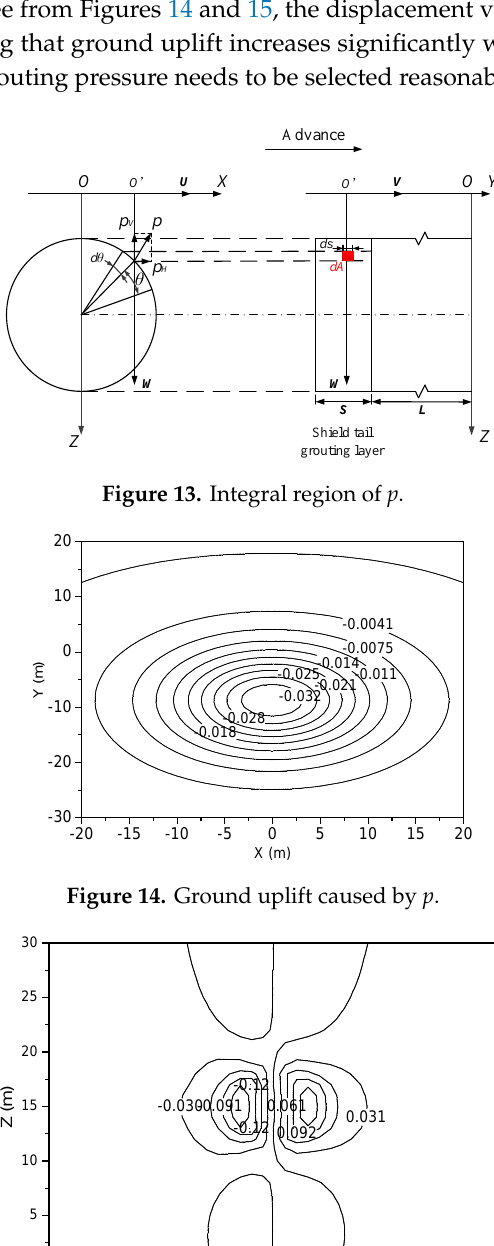
Figure 16. Ground uplift of different p . 5. Verification by Field Monitoring Data The stratum displacements induced by various effect factors and total displacement are shown in Table 3. The effect ratio of ground loss is over 95%, which plays a decisive role. The ratios to total of frictional force f d and f s are much less than 1%; they are too small to be considered. The ratios of additional thrust q and synchronous grouting pressure p are a little larger, but are no more than 3%. As shown in Figures 8 and 16, the variations of these two factors make some small quantitative changes, but no qualitative differences. It shows that this conclusion has good universality for different working conditions. The total ground settlement is compared with field monitoring data in Figure 17. From this, we can see that there are some differences between them. For example, the calculating settlement maximum is 10.25 mm, while monitoring data is 9.7 mm. The difference rate is 5.3%, which belongs to acceptable error range. What is more, they have the same trend and the